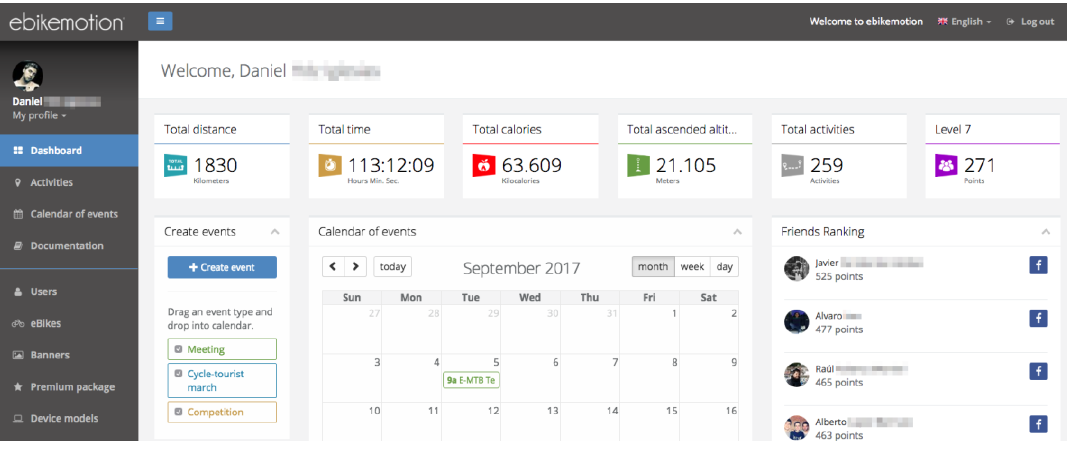
Figure 15. Screenshot of the visualization of results on the ebikemotion web application. The names of the users have been erased for privacy reasons.